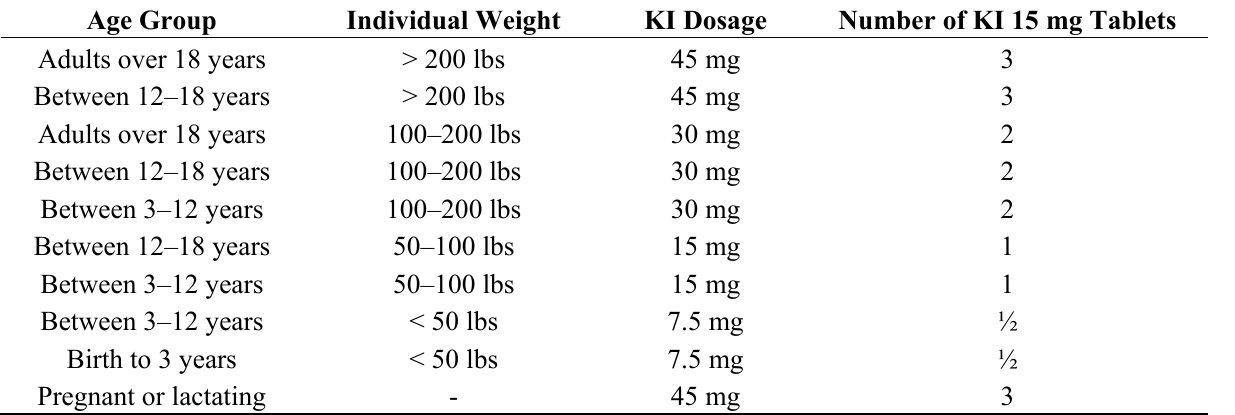
Table 2. Author recommendations for Potassium Iodide prophylactic dosage and number of tablets for different weight classes and age